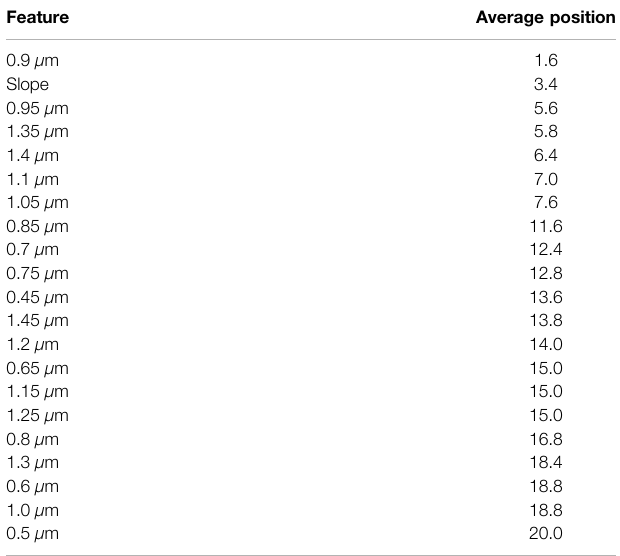
TABLE 7 | Average rank per feature for the classi fi cation of taxonomic types with accuracy during sequential feature selection on spectral features.